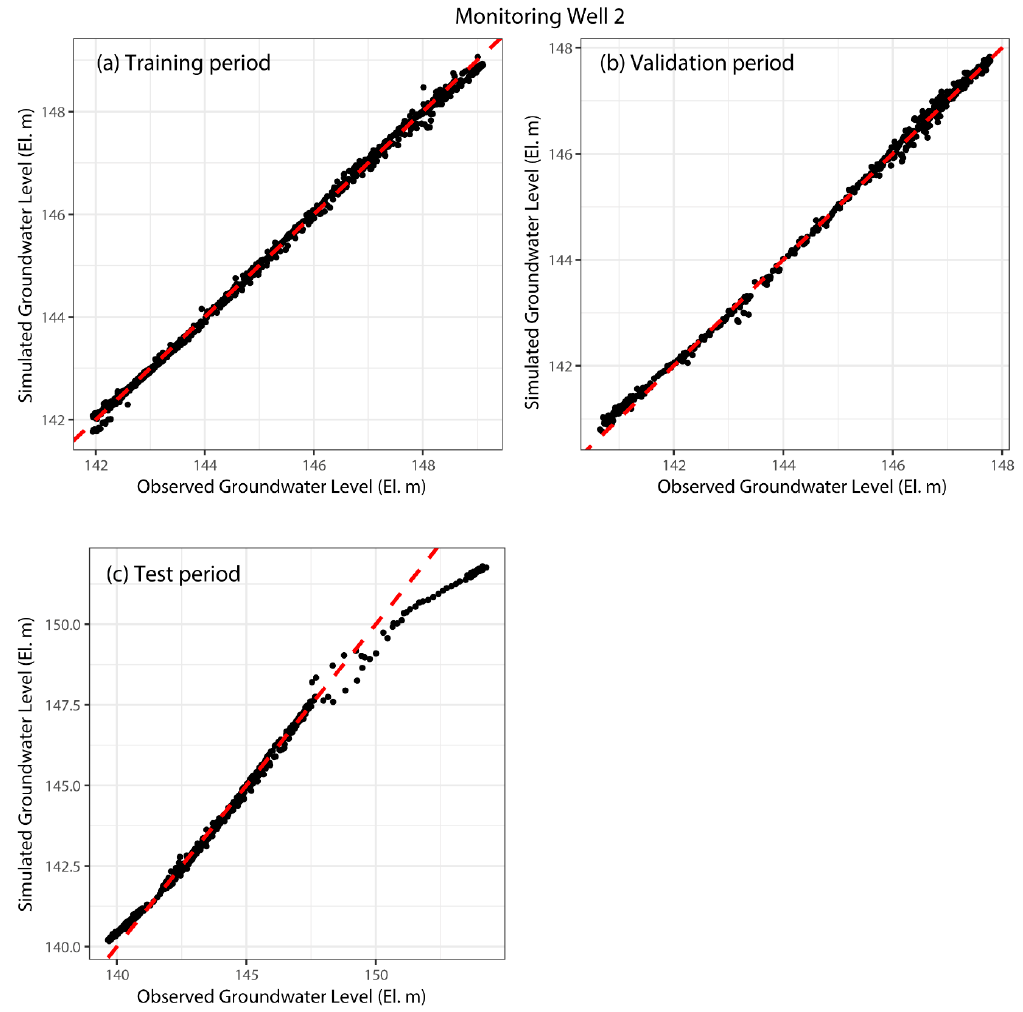
Figure 7. Simulated and observed groundwater levels for monitoring well 2. Table 4. Modeling performance of LSTM for the one-day groundwater level prediction.